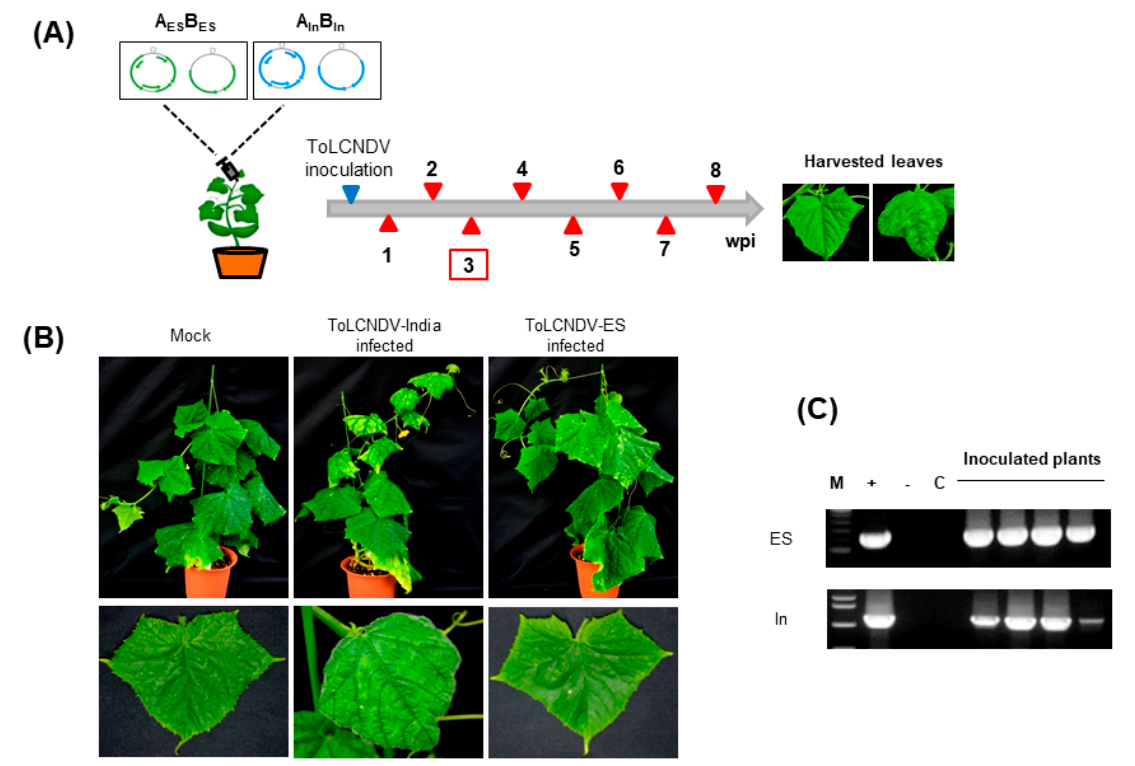
Figure 1. Infectivity of two ToLCNDV clones in cucumber: ( A ) Scheme of the experiment timeline from 1 to 8 weeks postinfection (wpi). At 3 wpi, symptoms appeared. and are marked with the red square. ( B ) Phenotype of the plants inoculated with empty Agrobacteria GV3101 (mock), ToLCNDV-India, and ToLCNDV-ES at 21 days postinfection (dpi). ( C ) PCR results to detect ToLCNDV in infected plants. Lane M, ladder; lane +, positive control; lane -, negative control; and lane C, mock plants. At 3 weeks postincubation (wpi), the mock-treated (pCAMBIA 1303 empty)